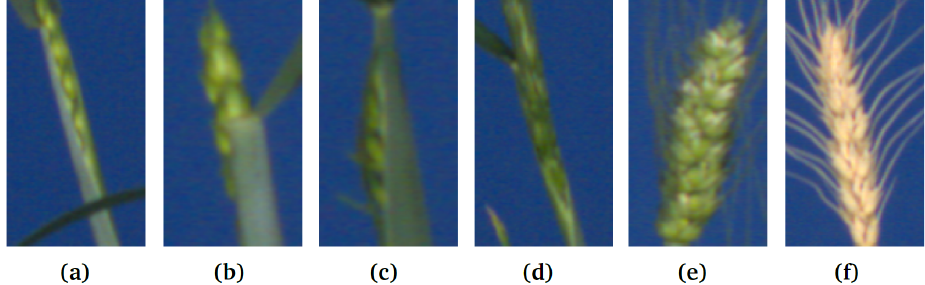
Figure 2. Examples of spike ROIs from the test image set: ( a – d ) emergent, partially visible spikes vs. ( e , f ) matured spikes (GSGC,